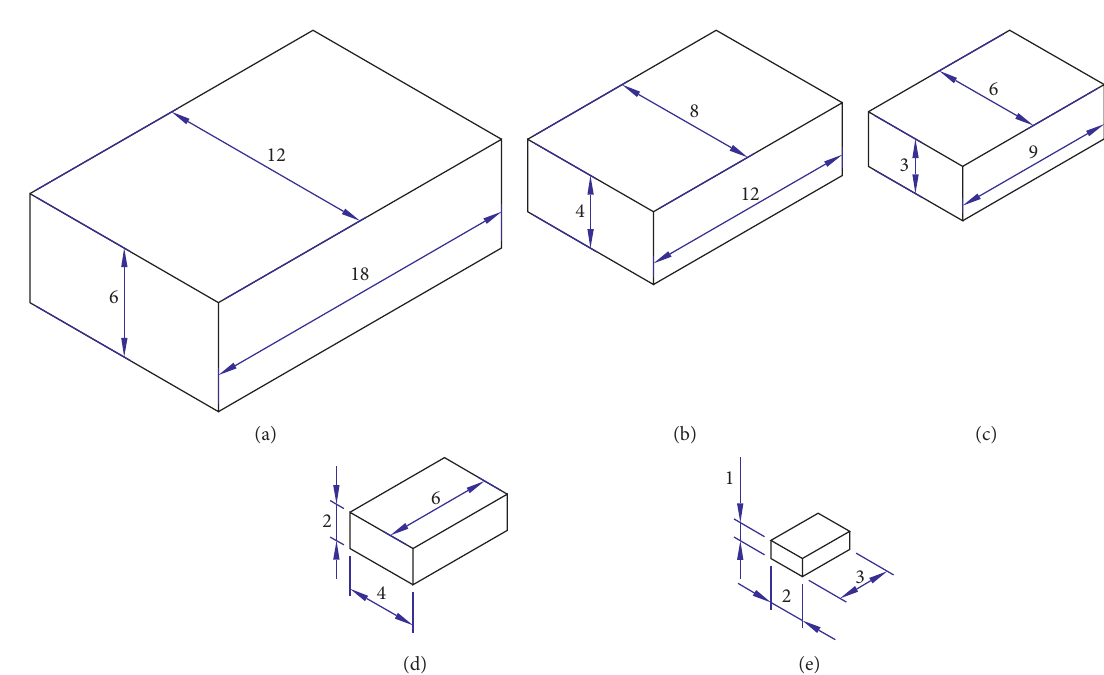
Figure 3: Sizes of concrete blocks; geometrical measurements were in